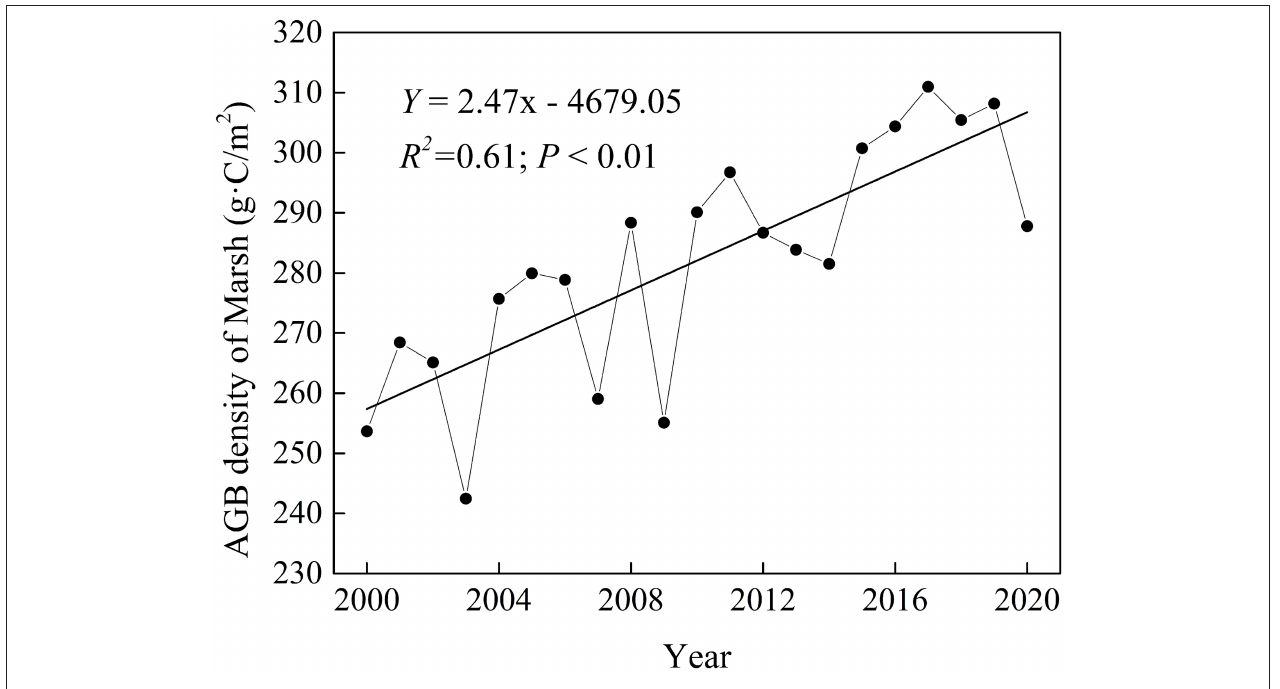
FIGURE 4 | Temporal variation of AGB density in Sanjiang Plain’s marshes during 2000–2020.